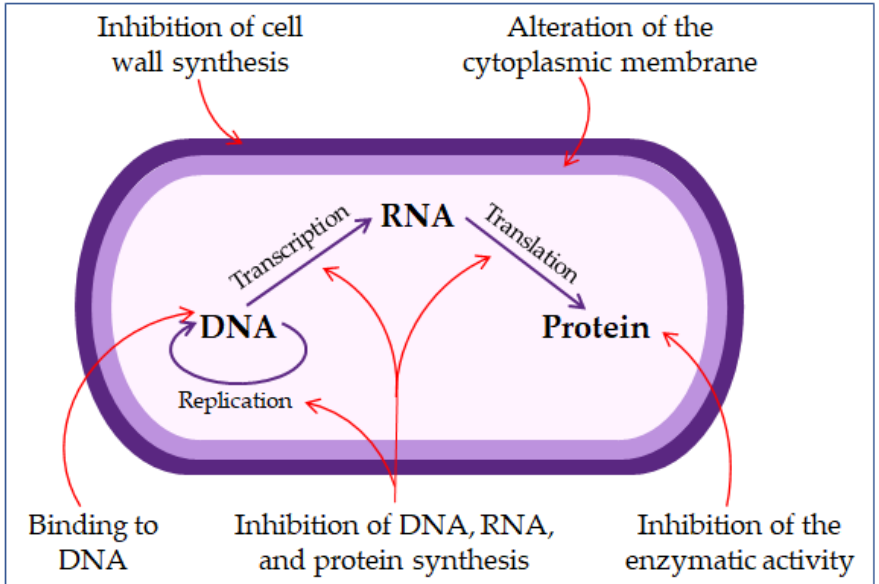
Figure 3. The mechanisms of antimicrobial peptides action.